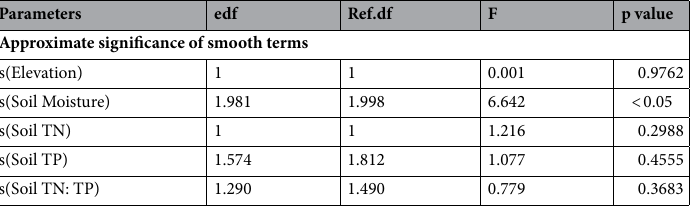
Table 3. General additive model for Miscanthus sacchariflorus to find out relationship among parameters. R-sq.(adj) = 0.864 Deviance explained = 92.2%. GCV = 29.554 Scale est. =